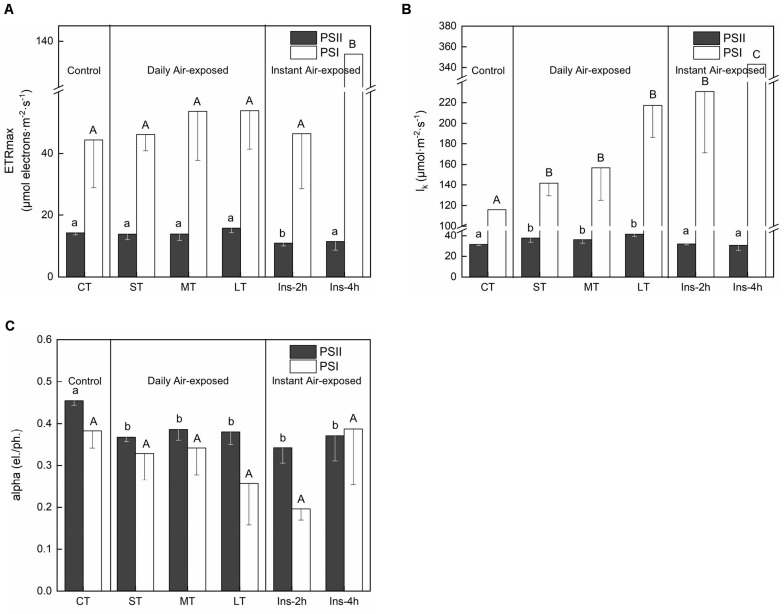
Rapid light curves fitting parameters under different air exposure treatments. (A) ETRmax estimated in PSII and PSI. (B) lk (half-saturation light intensity) estimated in PSII and PSI. (C) Alpha (initial slope of fitting curve) estimated in PSII and PSI. All data are expressed as means ± SD based on experiments in triplicate. Different letters over the columns indicate significant difference (P < 0.05) among means. Upper- and lower-case letters are used to distinguish different parameters within each figure part. CT: Control group without any air exposure; ST: 1 h of daily air exposure; MT: 2 h of daily air exposure; LT: 4 h of daily air exposure; Ins-2 h: instant air exposure of 2 h; Ins-4 h: instant air exposure of 4 h.